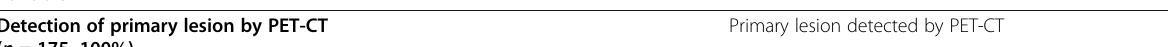
Primary lesion detected by PET-CT